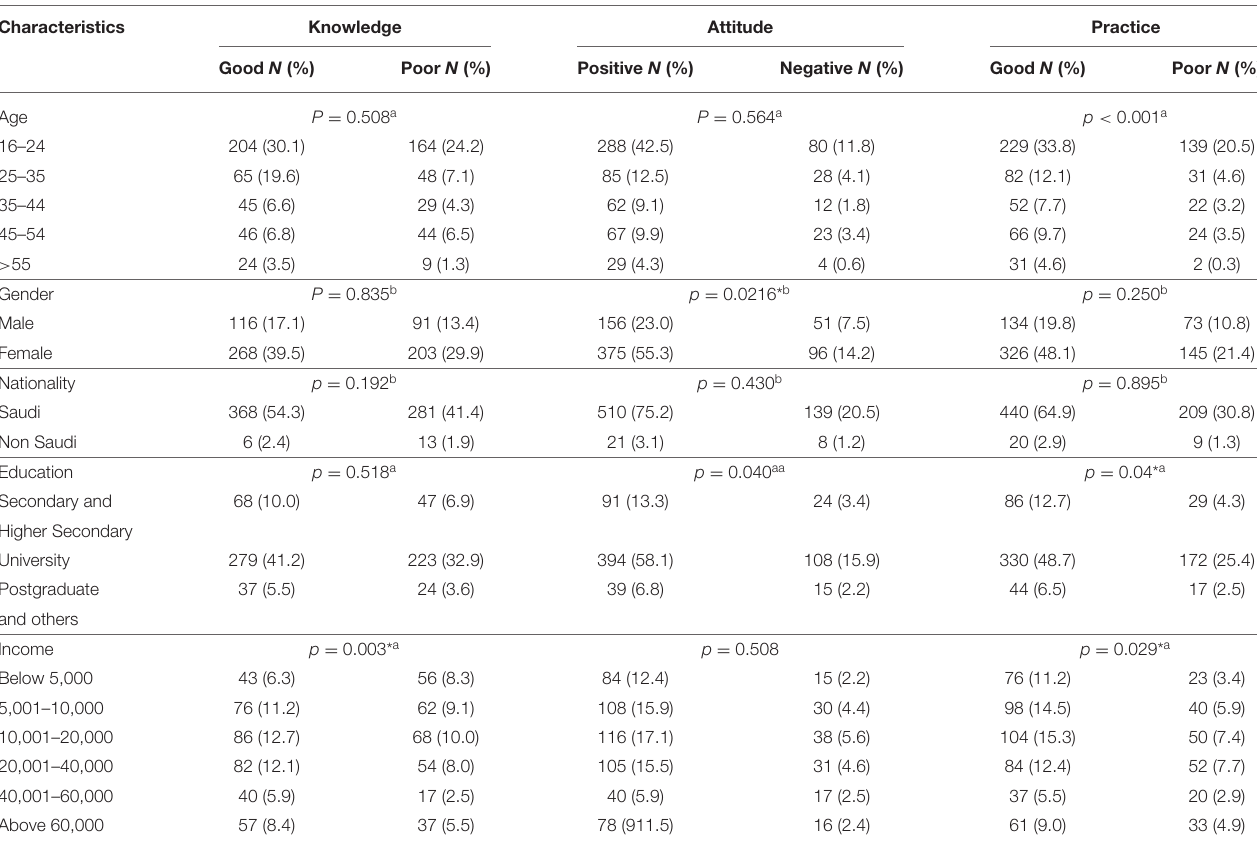
TABLE 3 | Association of knowledge, attitude, and practices of face mask use. Characteristics